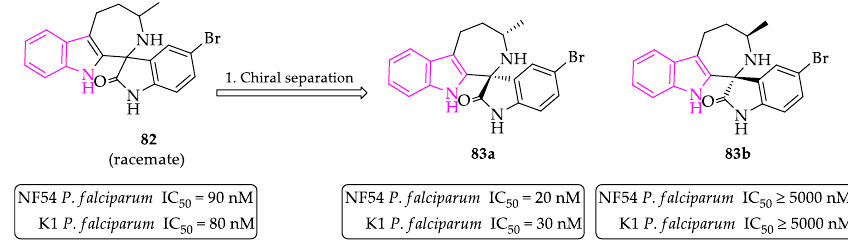
Figure 9. Activities of racemic spiroazepineindole 82 and individual stereoisomers.